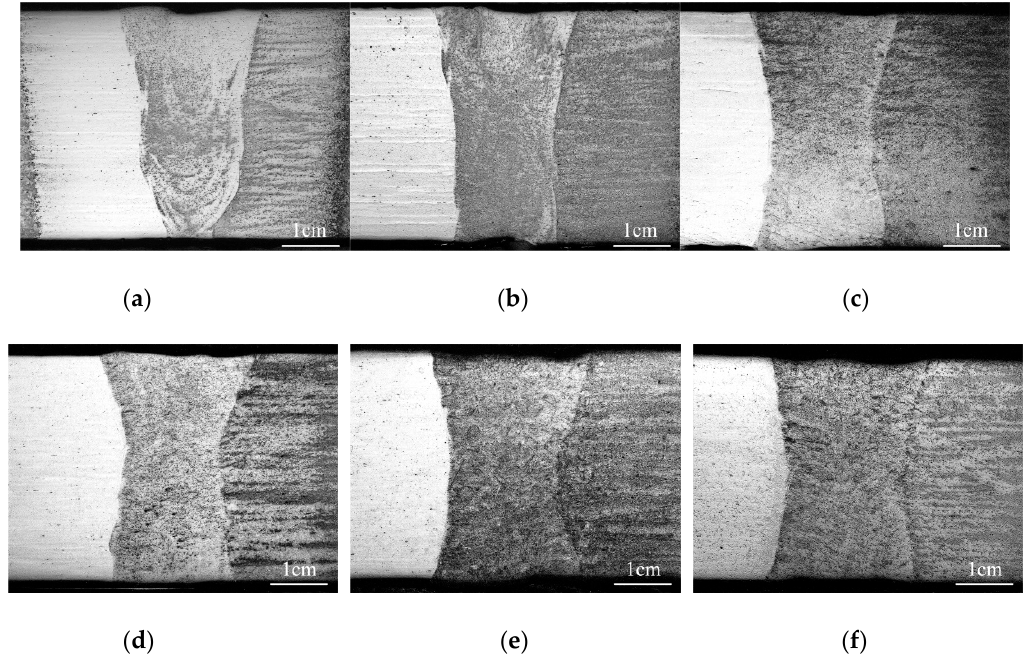
Figure 4. Effect of preheating on the cross-section of 42CrMo4/38MnVS6 laser welded joints: ( a ) without preheating; ( b ) 100 °C; ( c ) 150 °C; ( d ) 200 °C; ( e ) 250 °C; ( f ) 300 °C.